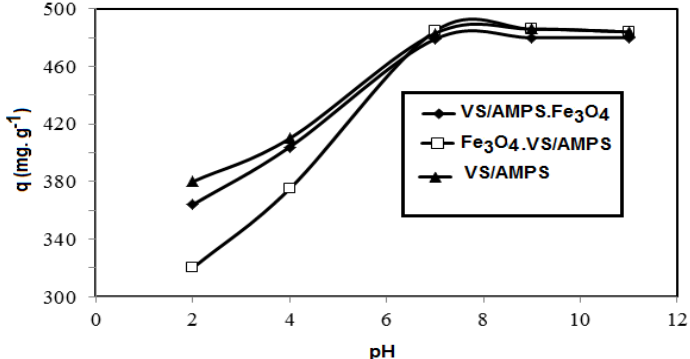
Figure 8. Effect of pH of water on the MB removal capacities of VS/AMPS cryogel and its magnetite composites at room temperature.